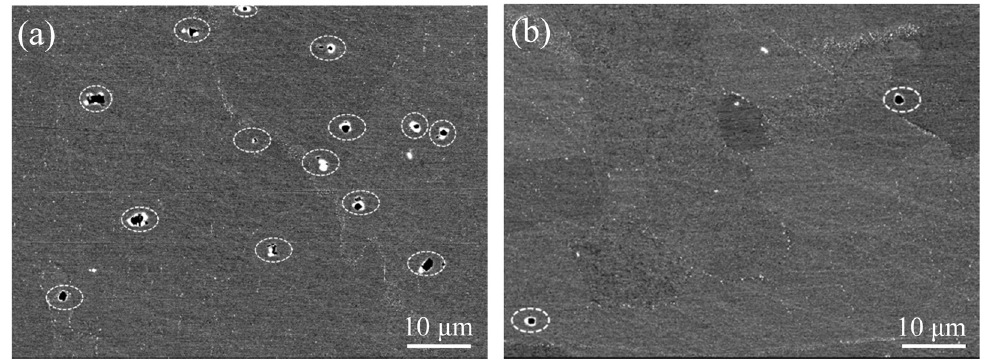
Figure 8: Surface morphology of samples after potentiostatic polarization. ( a ) FSS1 and ( b ) FSS2.